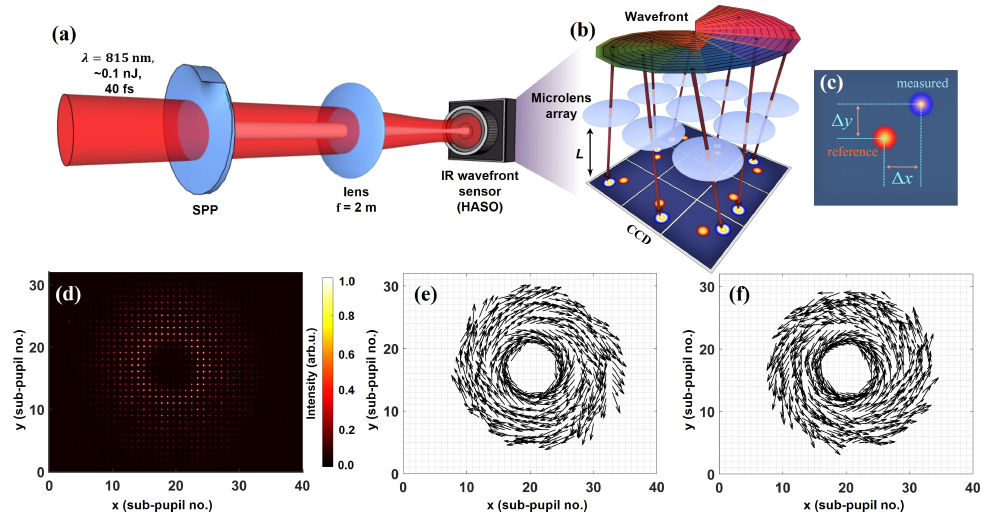
Figure 1. Vortex beam wavefront characterization setup. ( a ) Experimental setup for characterization of IR vortex beams. A low-energy ( ∼ 0.1 nJ) IR beam is passed through a spiral phase plate (SPP) to generate a vortex beam. The resulting beam is loosely focused by a 2 m focal length lens and directed towards a Shack-Hartmann wavefront sensor (HASO) located ∼ 300 mm after the focal plane. To generate a higher topological charge vortex, multiple SPPs of (cid:96) = 1 are inserted in the beam. In the insets ( b , c ), we show the working principle of the Shack-Hartmann wavefront sensor. The incoming beam is sampled by the microlens array of the sensor. Depending on the local wavevector direction, the sampled beamlets are displaced concerning the reference spots of the calibrated wavefront sensor, as shown in ( c ). The sampled spot distribution is acquired on a CCD camera located at a given distance (L) from the microlens array. An example raw Hartmanngram is presented in ( d ) for a vortex beam of (cid:96) = 4. The annular intensity profile of the vortex beam is evident from the central dark sub-pupils. From the raw Hartmanngram, the local slope, and ultimately the wavefront can be retrieved. In ( e , f ), the map of the measured slope for (cid:96) = + 4 and (cid:96) = − 4 are shown. The slopes maps show a spiraling behavior around the center, whose direction of rotation changes from clockwise ( e ) to counterclockwise ( f ) with a change in sign of (cid:96)